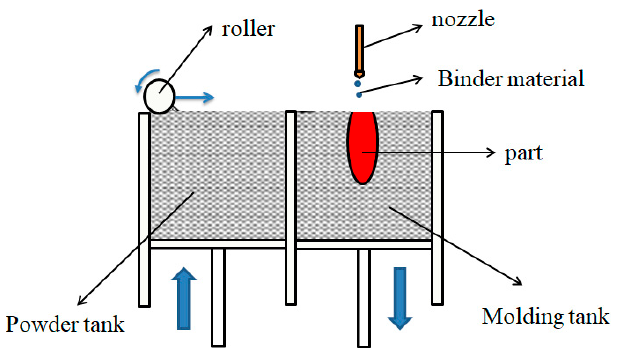
Figure 4. Working scheme of binder jetting technology (BJ). Figure 4. working scheme of binder jetting technology (BJ). Figure 4. working scheme of binder jetting technology (BJ).